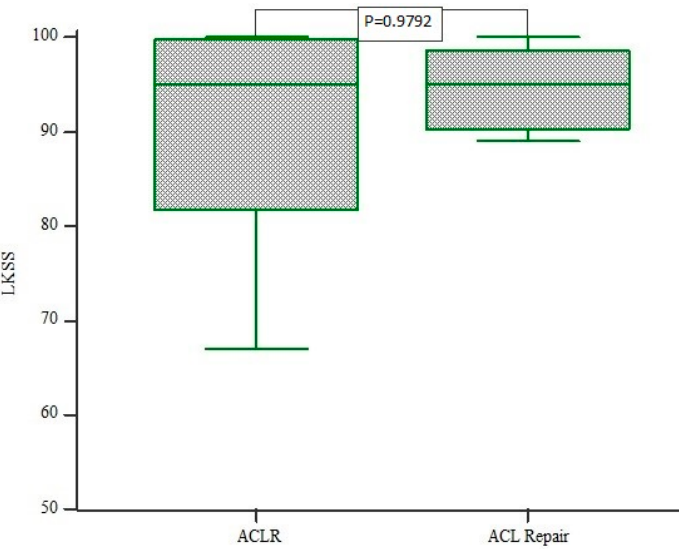
Figure 6. Box plot of Lysholm score assessments comparing ACL repair and ACLR group. The mean Lysholm score after 12 months was 89.2 (range: 57–100) in the internal bracing cohort and 89.9 (range: 67–100) in the ACLR group. There were no statistically significant differences between both groups ( p = 0.9793).